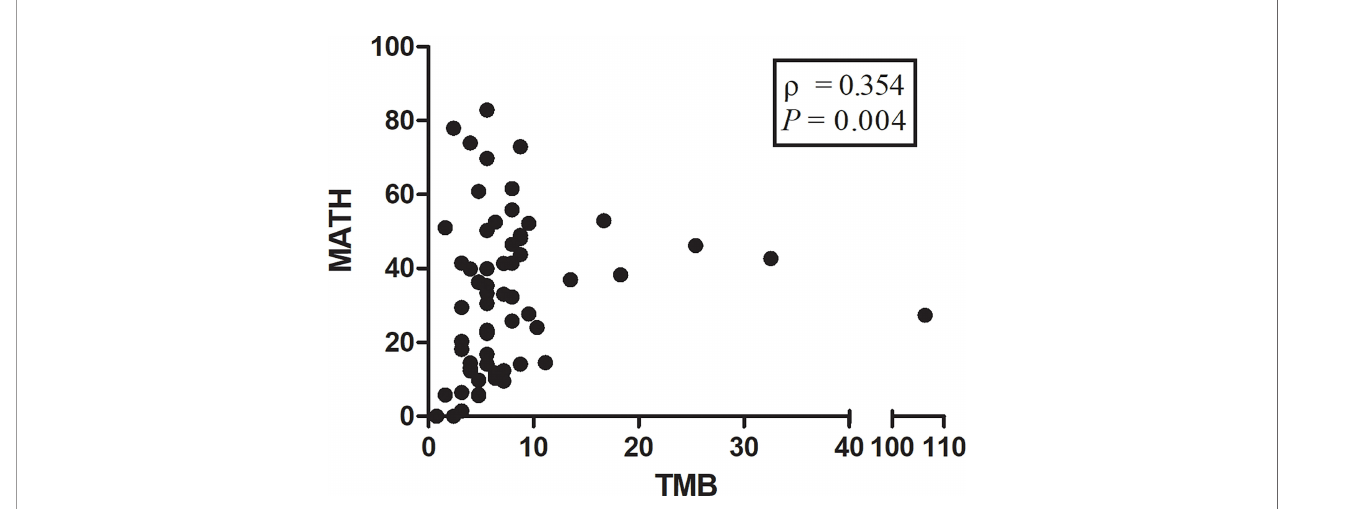
FIGURE 6 | Scatterplot showing correlation between mutant-allele tumor heterogeneity (MATH) score and tumor mutational burden (TMB) score. The r value represents Spearman ’ s rank correlation. Spearman r = 0.354; P = 0.004.